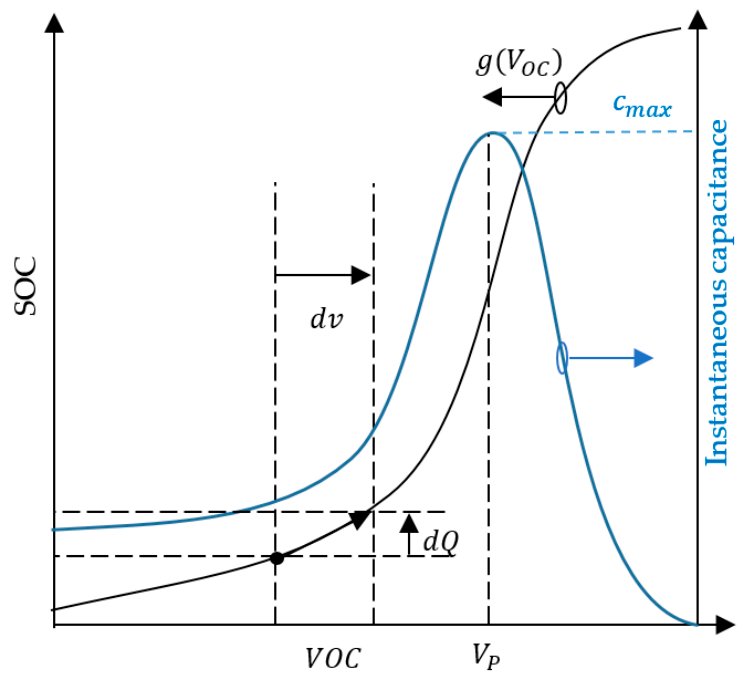
Figure 4. The shifted sigmoid and the instantaneous capacitance of the battery.